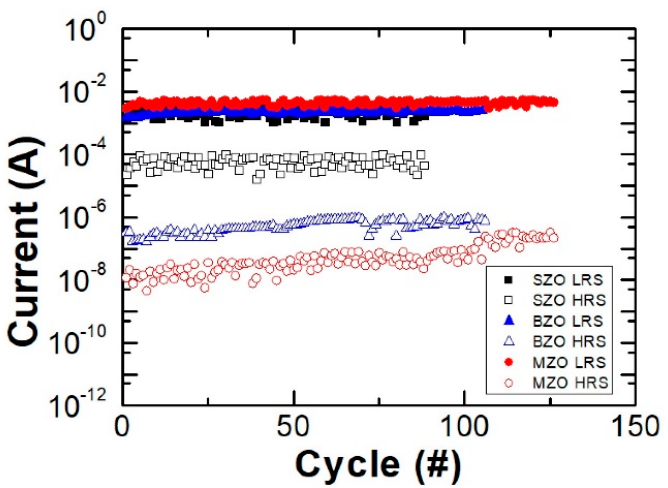
Figure 6. Endurance performance of Al/SZO/ITO, Al/BZO/ITO, and Al/MZO/ITO RRAM operated under DC bias mode at RT.